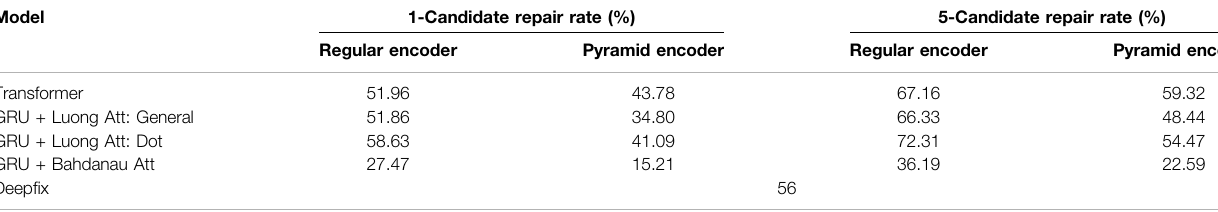
TABLE 5 | Comparison of our models with Deep fi x, Gupta et al., (2017) on Deep fi x dataset. All results are average of 5-fold cross validation. Model